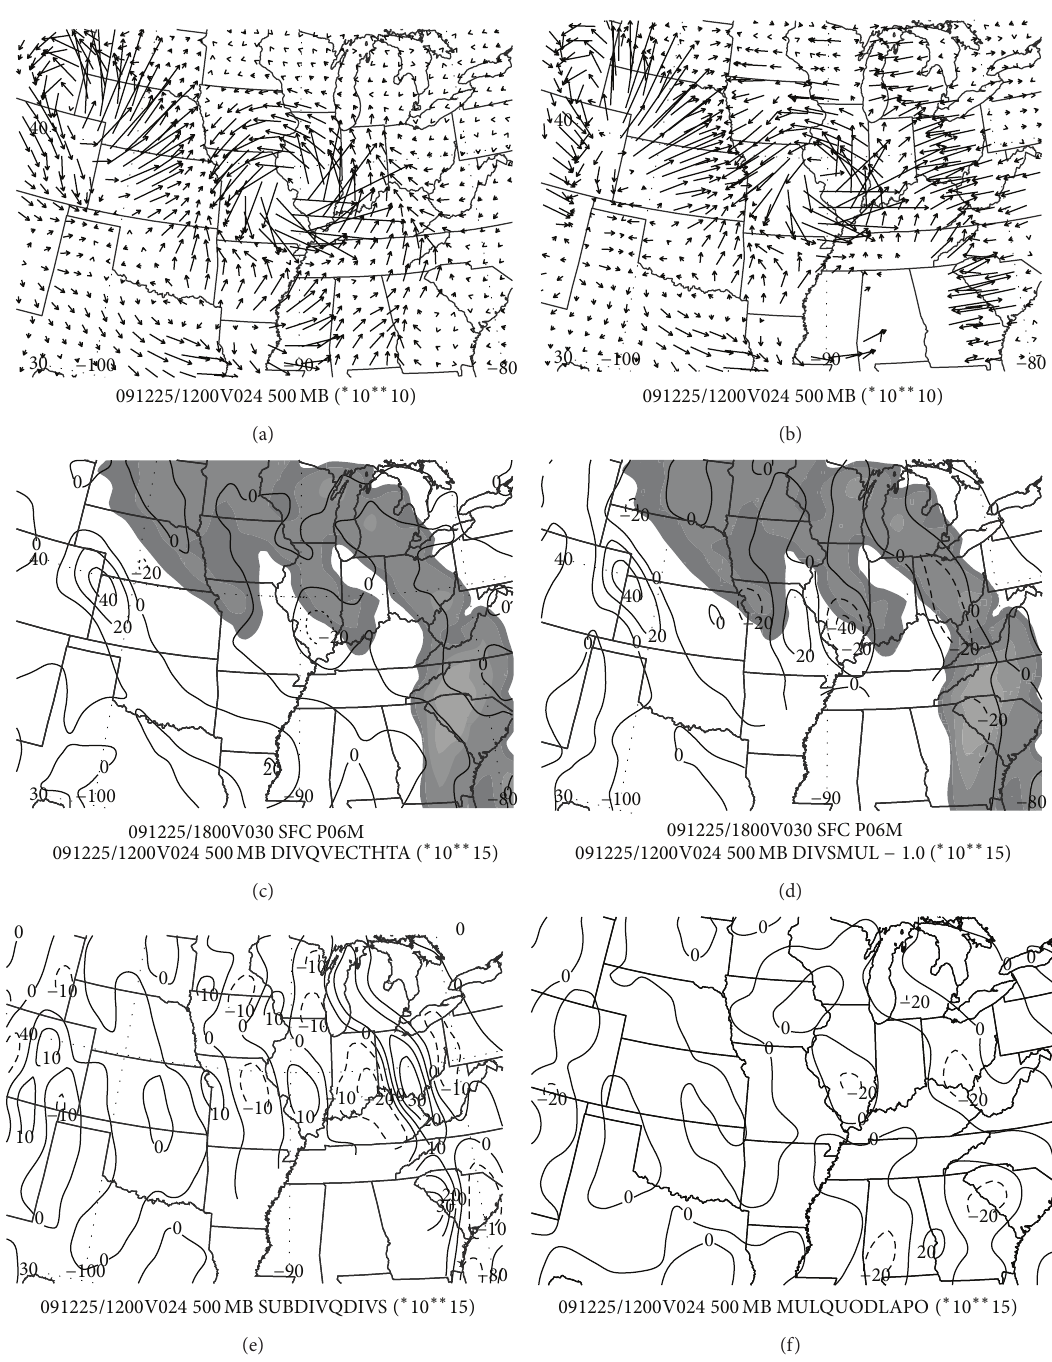
Figure 6: As in Figure 5, but from the NAM model run initialized at 1200 UTC 24 December 2009 and valid at 1200 UTC 25 December 2009 (24-hour